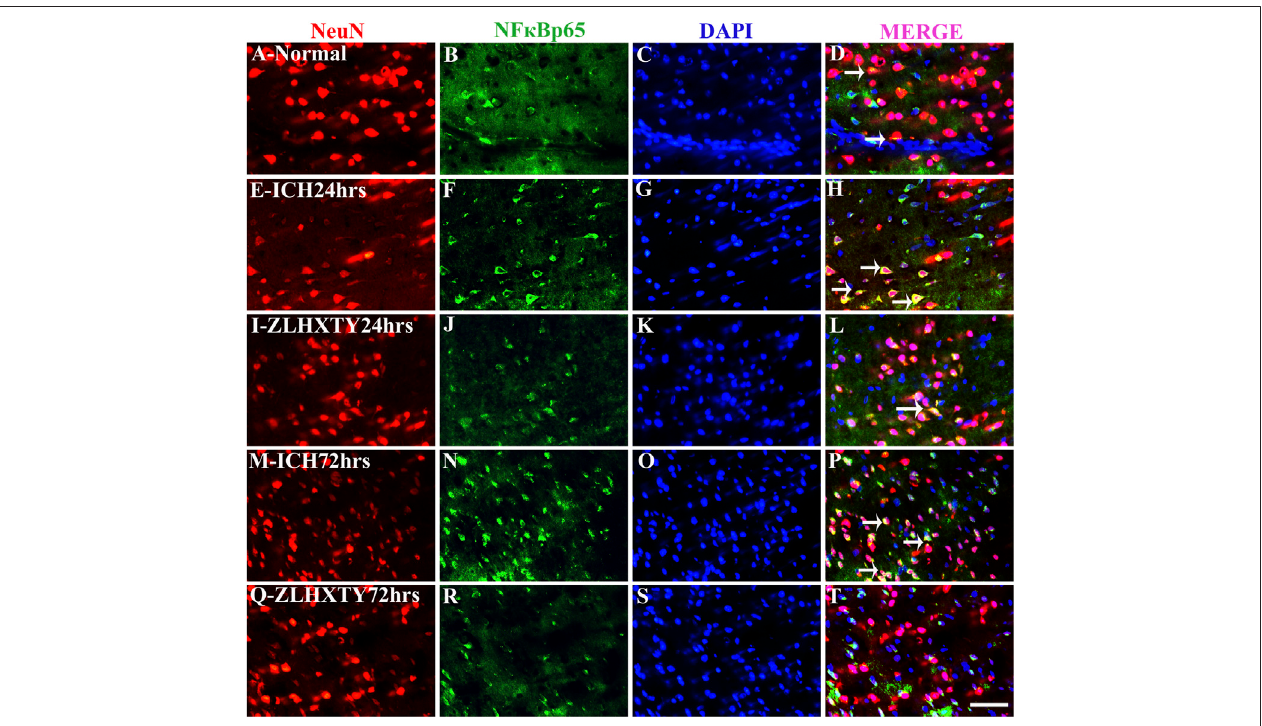
FIGURE7| Doubleimmuno fl uorescenceofNeuNandNF κ B-p65.Brainsectionsweretriple-stainedwithanti-NeuN(red),anti-NF κ B-p65(green)andDAPI(blue)to mark neurons, NF κ B-p65 and nucleus. (A – D) , Normal brain section shows very weak NF κ B-p65 staining in some neurons co localized with NeuN. (E – H) , ICH 24 h group show increased neuronalNF κ B-p65 expression with decrease in number of NeuNexpressingneurons ascompared tonormal. (I – L) , ZLHXTY 24 h group shows increasedNeuNnumberandreductioninNF κ B-p65expression. (M – P) ,ICH72 hshowreducedNeuNexpressioninneuronsco-expressinghigherlevelsofNF κ B- p65. (Q – T) , ZLHXTY 72 h group show obvious reduction in neuronal NF κ B-p65 expression and increased NeuNnumber and expression. Respective changein color in merged fi gures D,H,L,P,T, corresponds to Red + Blue = Magenta; Red + Green = Yellow. 50 µm scale bar corresponds to 400 × magni fi